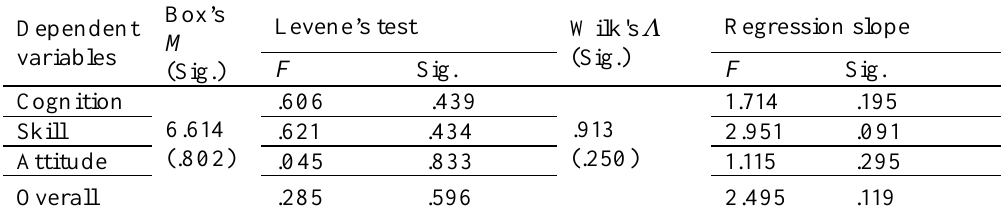
Test of Homogeneity for Posttests on Self-Assessment of Both Groups Dependent variables